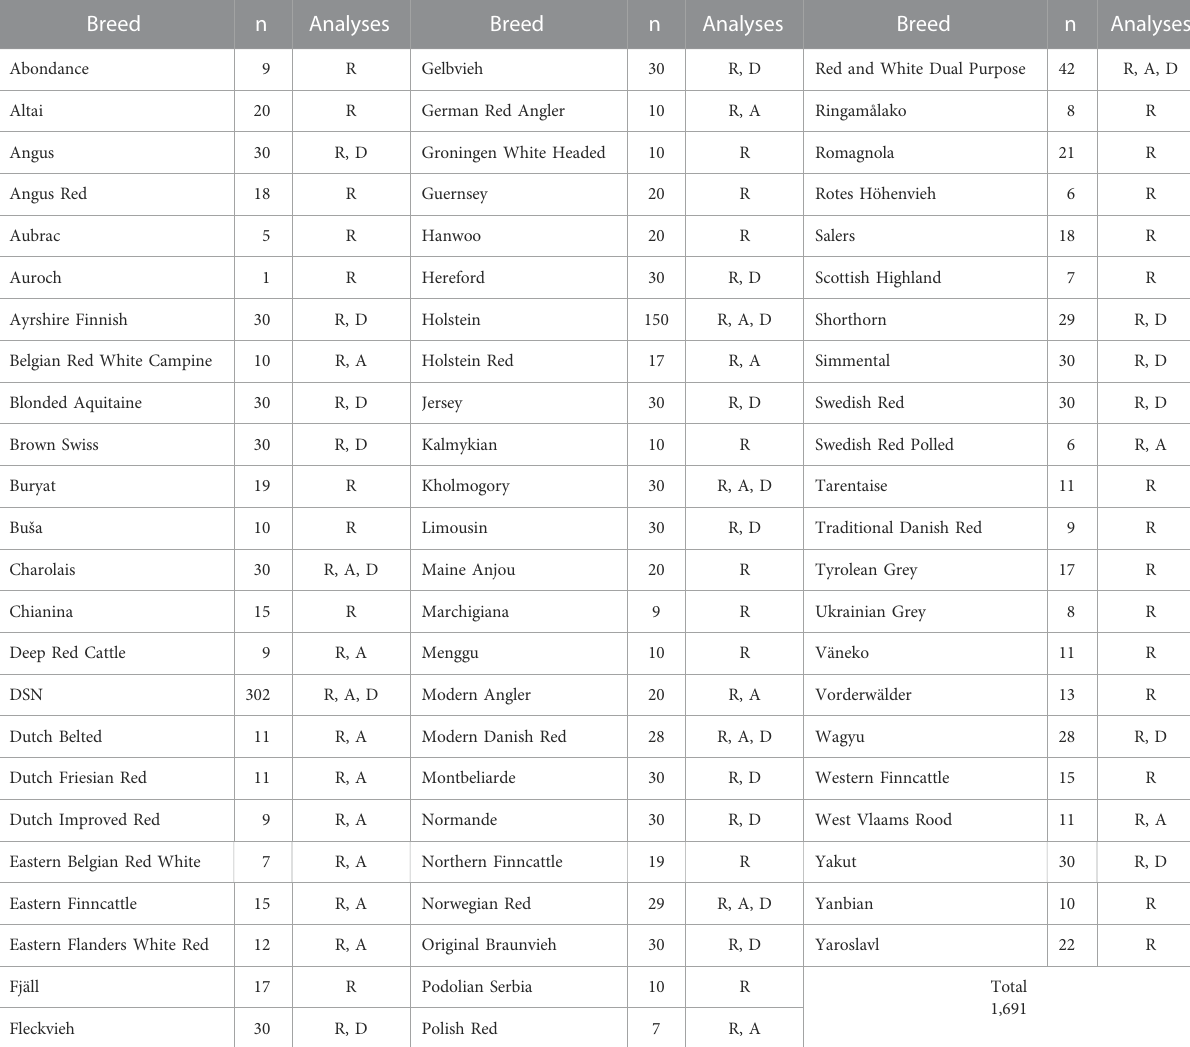
TABLE1Numberofanimalsselectedperbreedandanalysesinwhichthey wereincluded. Rstandsfor ‘ Relationship ’ includingphylogenyandF ST (allbreeds), A stands for ‘ Admixture ’ (20 breeds with highest F ST ), and D for ‘ Diversity ’ (24 breeds with ≥ 25